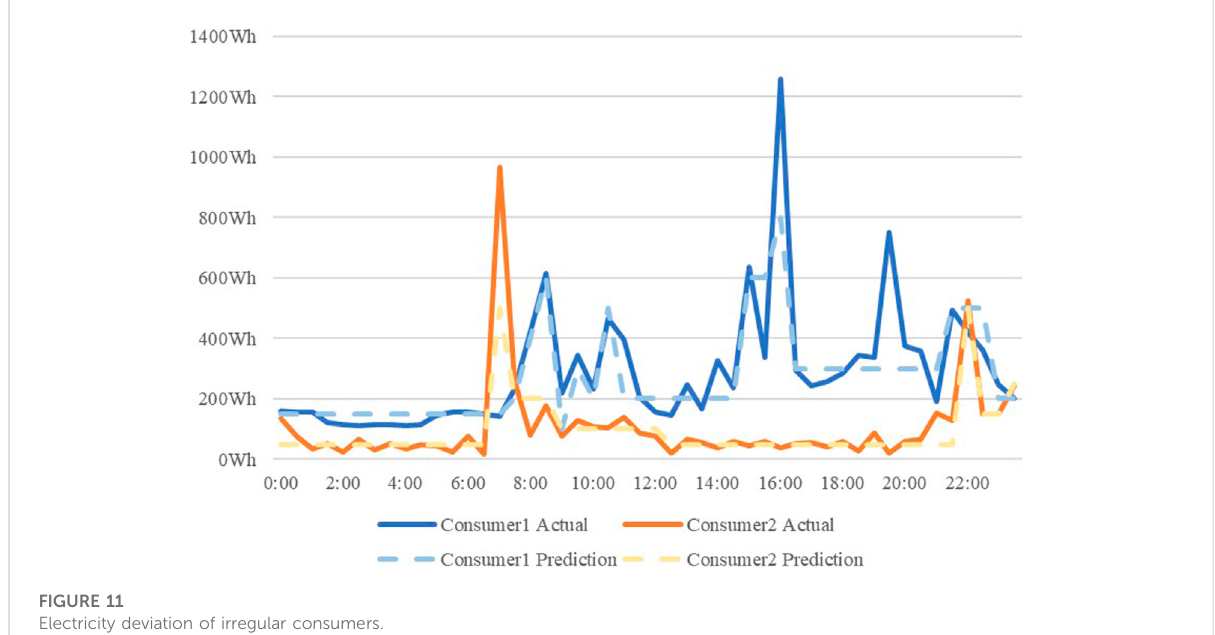
FIGURE 11 Electricity deviation of irregular consumers.